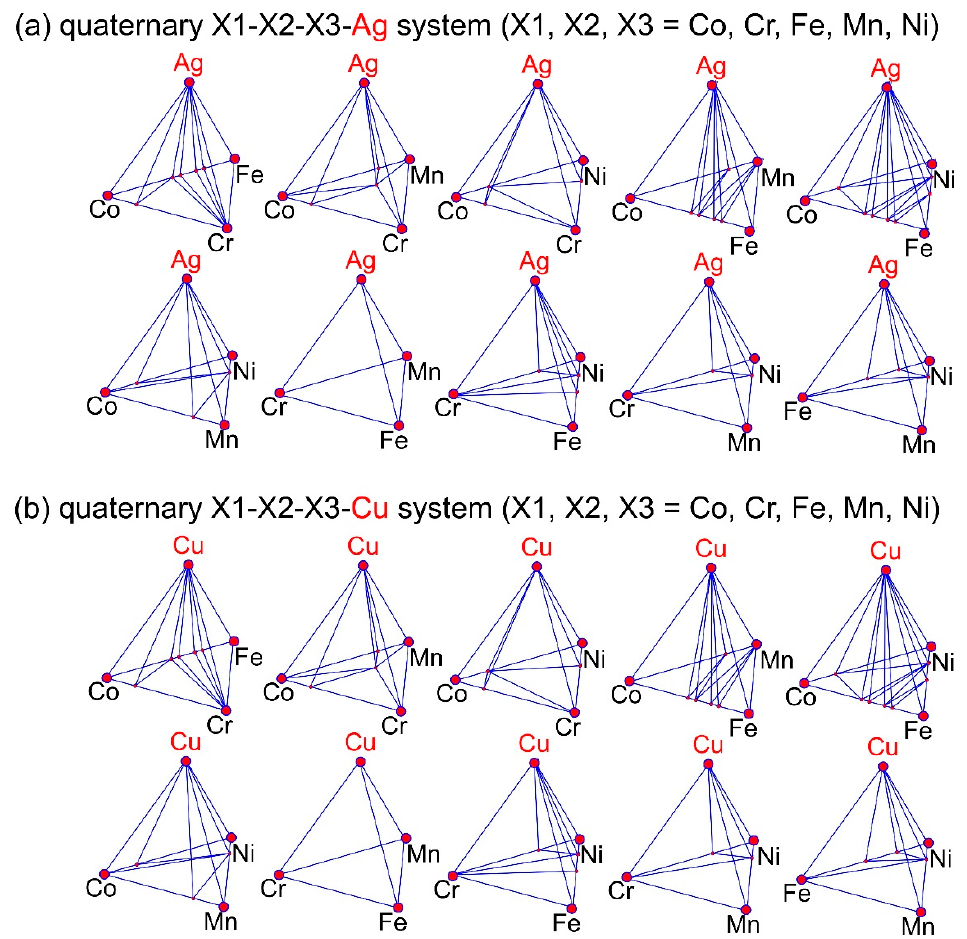
Figure 2. Predicted quaternary phase diagrams constructed by the Materials Project. ( a ) X1-X2-X3-Ag (X1, X2, X3 = Co, Cr, Fe, Mn, Ni) alloy systems based on the Ag-Co-Cr-Fe-Mn-Ni alloy system, ( b ) X1-X2-X3-Cu (X1, X2, X3 = Co, Cr, Fe, Mn, Ni) alloy systems based on the Co-Cr-Cu-Fe-Mn-Ni alloy system.